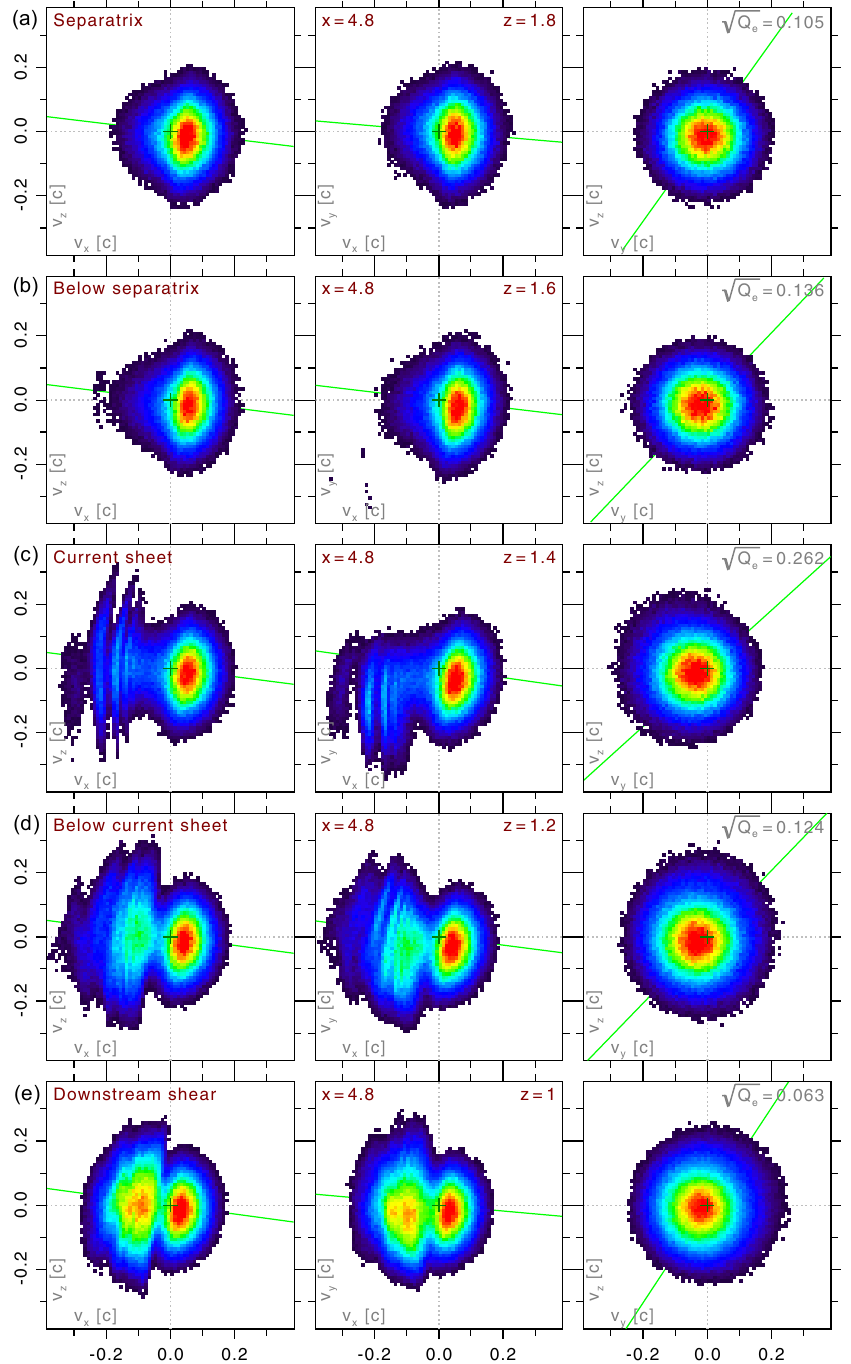
Figure 10. Same as Fig. 5 but near the separatrix layer across an electron up-/downstream shear